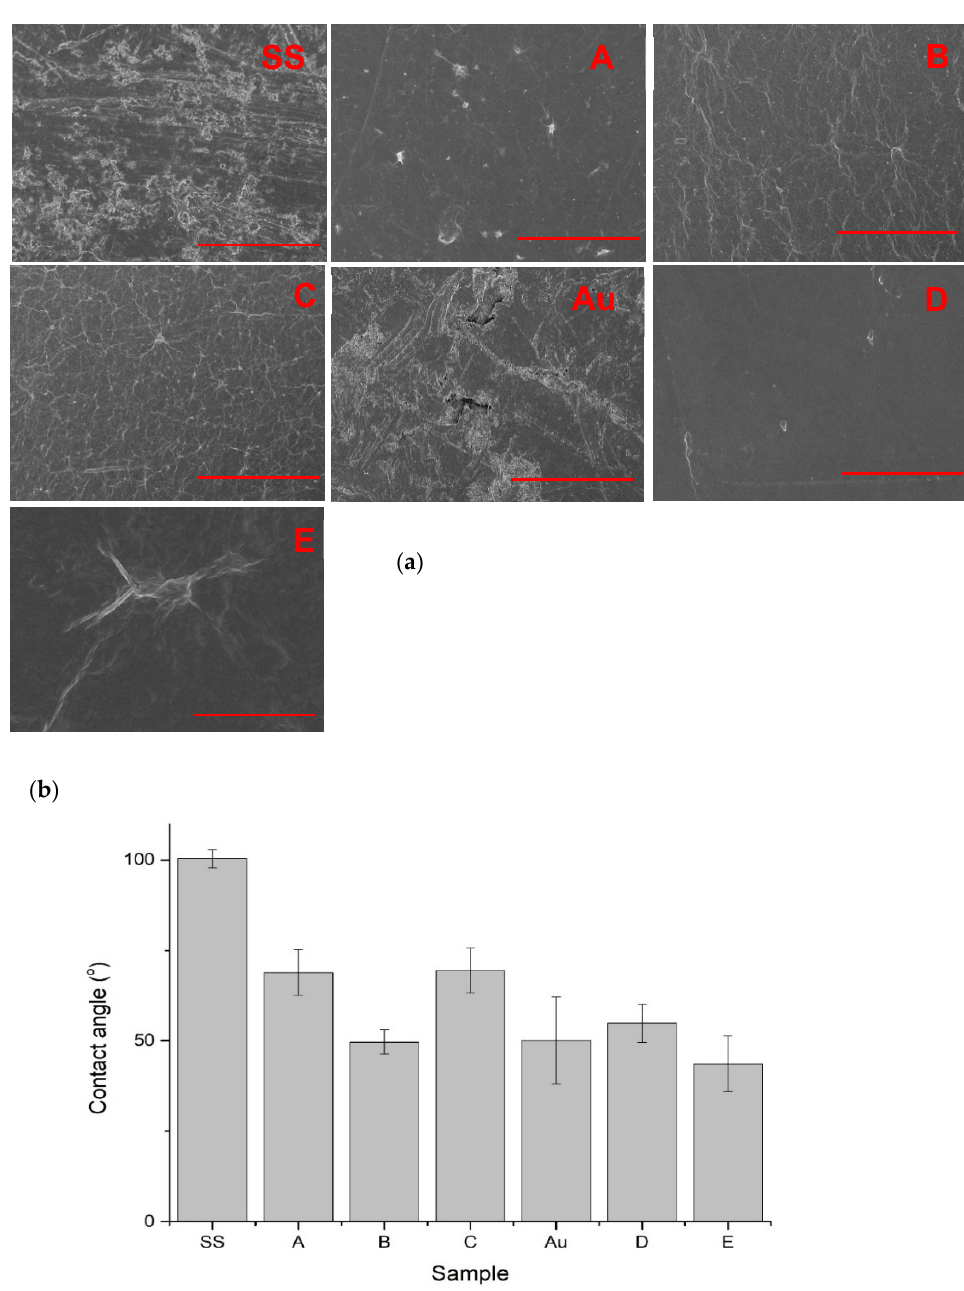
Figure 3. ( a ) SEM images of surfaces of obtained materials (variant numbers are shown in red in the upper-right corner), reference bar for SS, A, B, C, and D is 50 µ m and for E is 5 µ m. ( b ) Graph showing the decrease in contact angle with water for the treated sample.